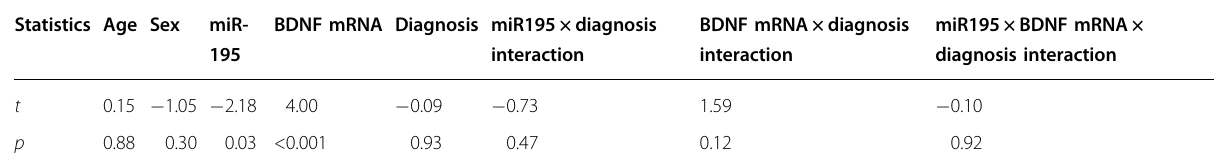
Table 3 Full model regression analysis statistics where BDNF protein level is the dependent variable. Statistics Age Sex